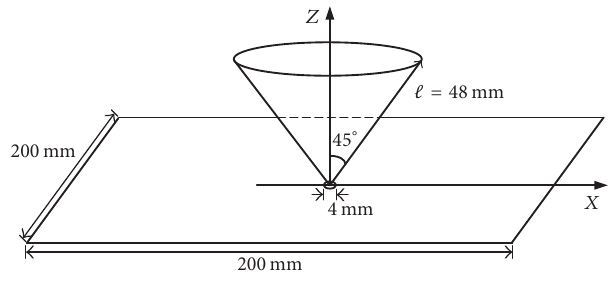
Figure 1: Geometry and dimensions of primitive UWB